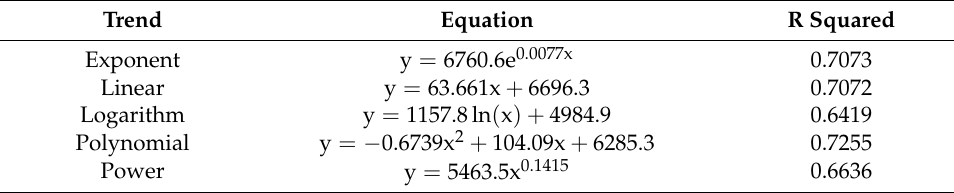
Table 6. Equations of variation trends for top yields of world rice from 1961 to 2019. Trend Equation R Squared Exponent y = 6760.6e